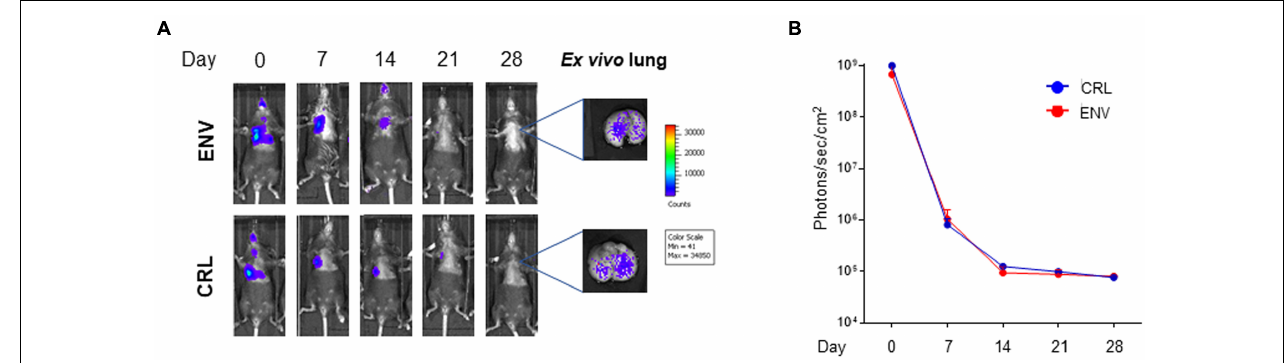
FIGURE 4 | In vivo and ex vivo imaging of intratracheally (IT) injected mouse bone marrow-derived mesenchymal stromal/stem cells (mBM-MSCs) from different sources. (A) In vivo bioluminescence imaging (BLI) of IT mBM-MSC clone #2LucRi/GFP inoculated Charles River Laboratories (CRL) and Envigo (ENV) mice. Mice were weekly monitored up to 4 weeks post inoculation. On day 28, mice were anesthetized and lungs were harvested for ex vivo imaging using In Vivo Imaging System (IVIS) BLI system. No significant differences were detected between the two strains of mice, thus host genetic background does not impact cell persistency into the lung ( p > 0.05, two-way ANOVA test followed by Sidak’s test for multiple comparisons). (B) BLI signal from each mouse was quantified five times, expressed as photons/s/cm 2 and plotted as mean ± SEM. BLI signal at each time point represents the mean ± standard deviation of five